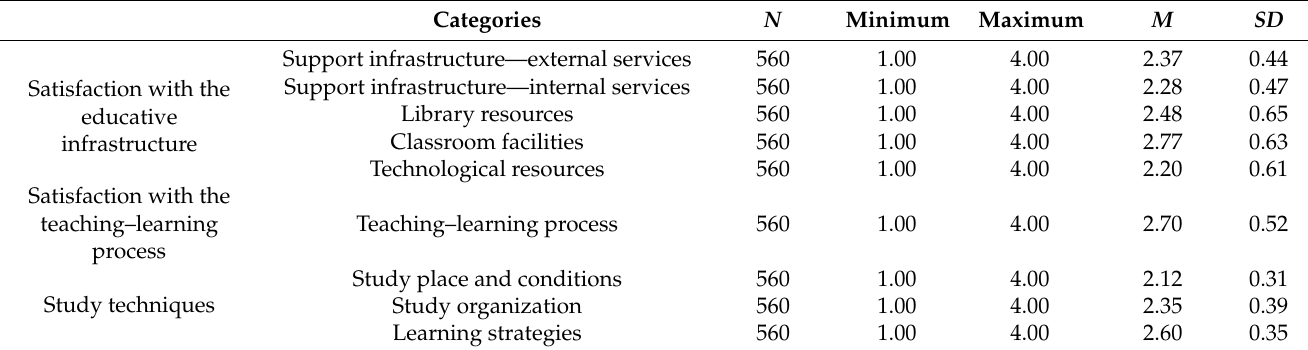
Table 2. Descriptive statistics in each category of the